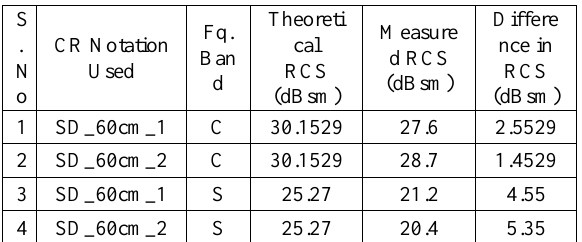
Table 4: RCS measurements for Dihedral corner reflectors at C and S band in VV Polarization